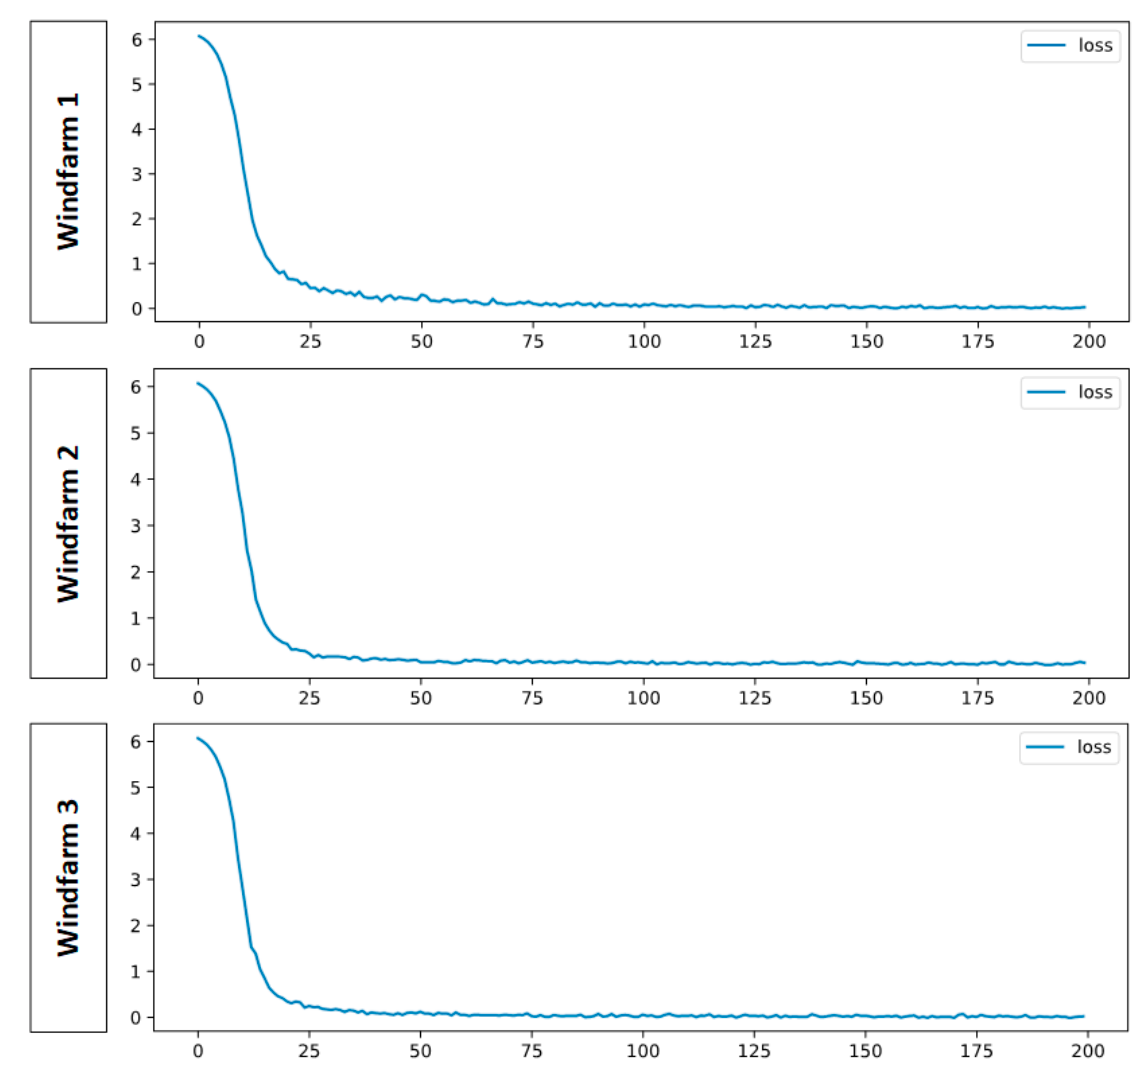
15 of 21 Table 5. Comparison of related forecasting models with the proposed model in terms of Normalized MAE and RMSE forecasting errors. Dataset Errors